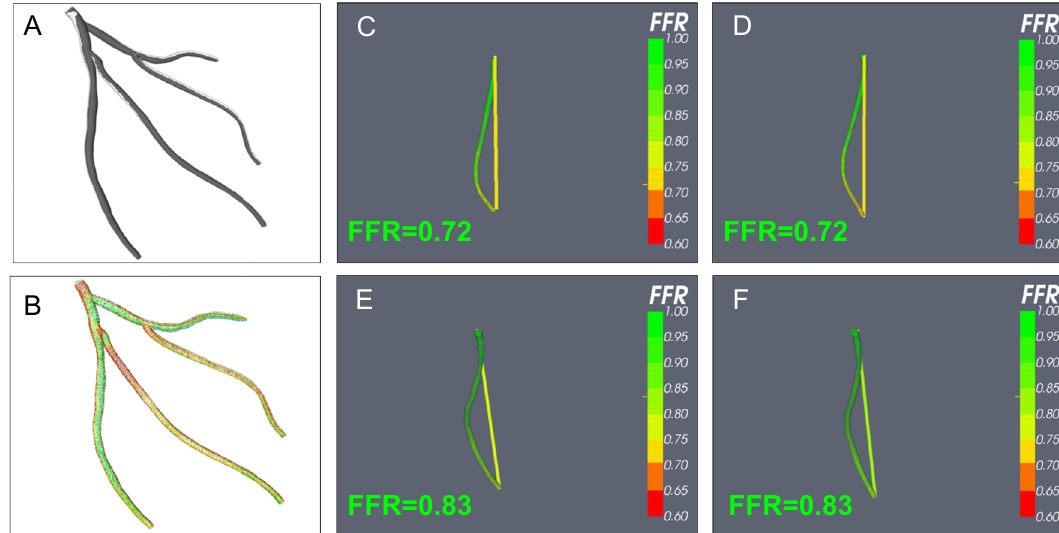
Figure 4. vFFR analysis. Individual braches of the reference file ( A ) and the 3D CA reconstructed artery ( B ) were subjected to vFFR analysis under identical conditions. ( C , D ) Show the obtuse marginal branch from the reference file ( C ) and 3D CA ( D ). Excellent anatomical reconstruction means that both fluid dynamics analyses result in vFFR of 0.72. ( E , F ) Demonstrate the analysis for the left anterior descending branch. In this branch both the reference and 3D CA reconstructed vessles have a vFFR of 0.83